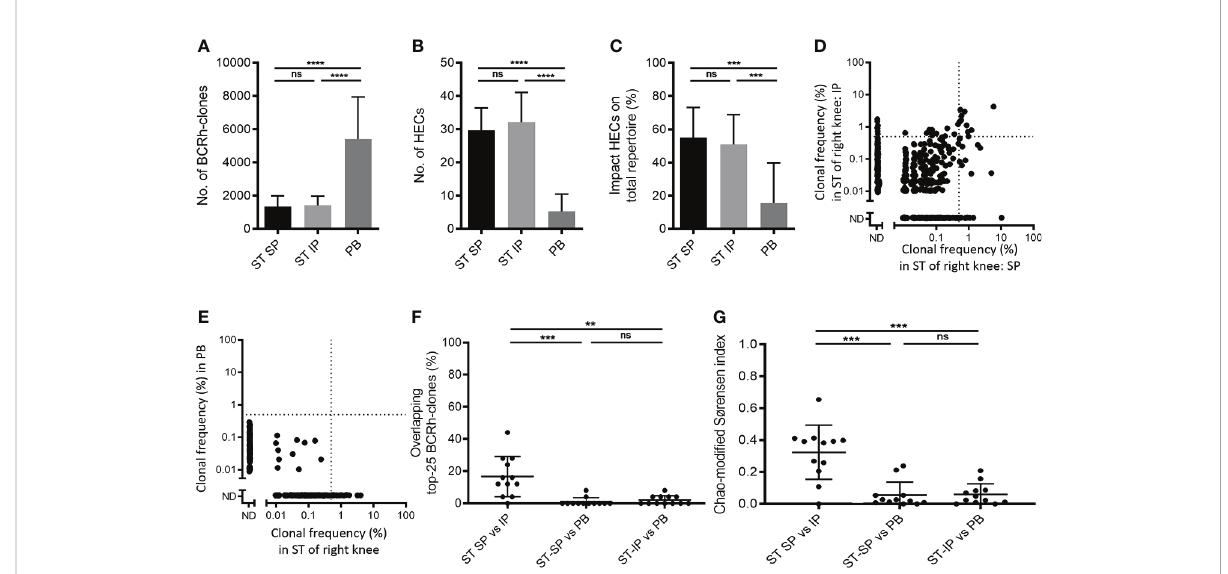
FIGURE 1 Comparing B-cell receptor repertoires within one joint. Bar charts of (A) the number of BCR-clones, (B) number of highly expanded BCR-clones (HECs) and (C) impact of HECs on total repertoire per compartment (bars show mean and SD; ** p<0.01 and **** p<0.0001 using a Tukey ’ s multiple comparison test; ns=not signi fi cant). (D) Representative example of overlap-plot in one patient comparing the suprapatellar (SP) to the infrapatellar (IP) synovial tissue (ST) region, showing overlap of dominant BCR-clones in the upper right quadrant. Each dot re fl ects the frequency of the clone (% of total number of reads) in the ST-IP on the Y-axis and in the ST-SP on the X-axis. Vertical and horizontal dotted lines indicate the 0.5% threshold for HECs. ND=not detected; (E) Representative example of a comparison of ST to peripheral blood (PB), showing little overlap. For explanation of graph see (D) above. Scatter plots of (F) percentage of overlapping top-25 BCR-clones and (G) Chao- modi fi ed Sørensen indices of the total BCR-clones repertoire when comparing different compartments (n=12; lines at mean and SD; * p<0.05, ** p<0.01 using a paired t test; ns=not signi fi